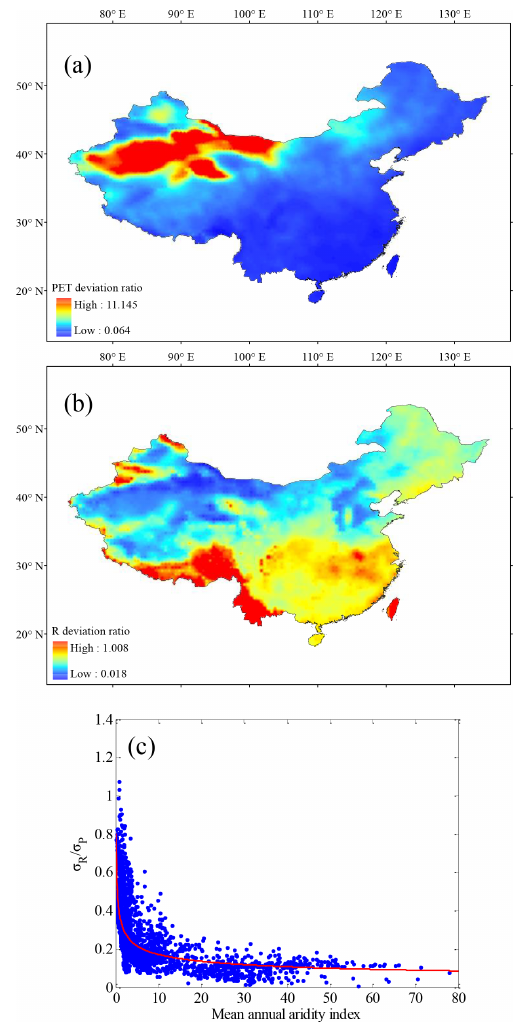
Figure 4. Spatial distributions of (a) PET deviation ratio and (b) R deviation ratio and (c) the relationship between R deviation ratio and mean annual aridity index ( φ ) for all 0.5 ◦ grid points in